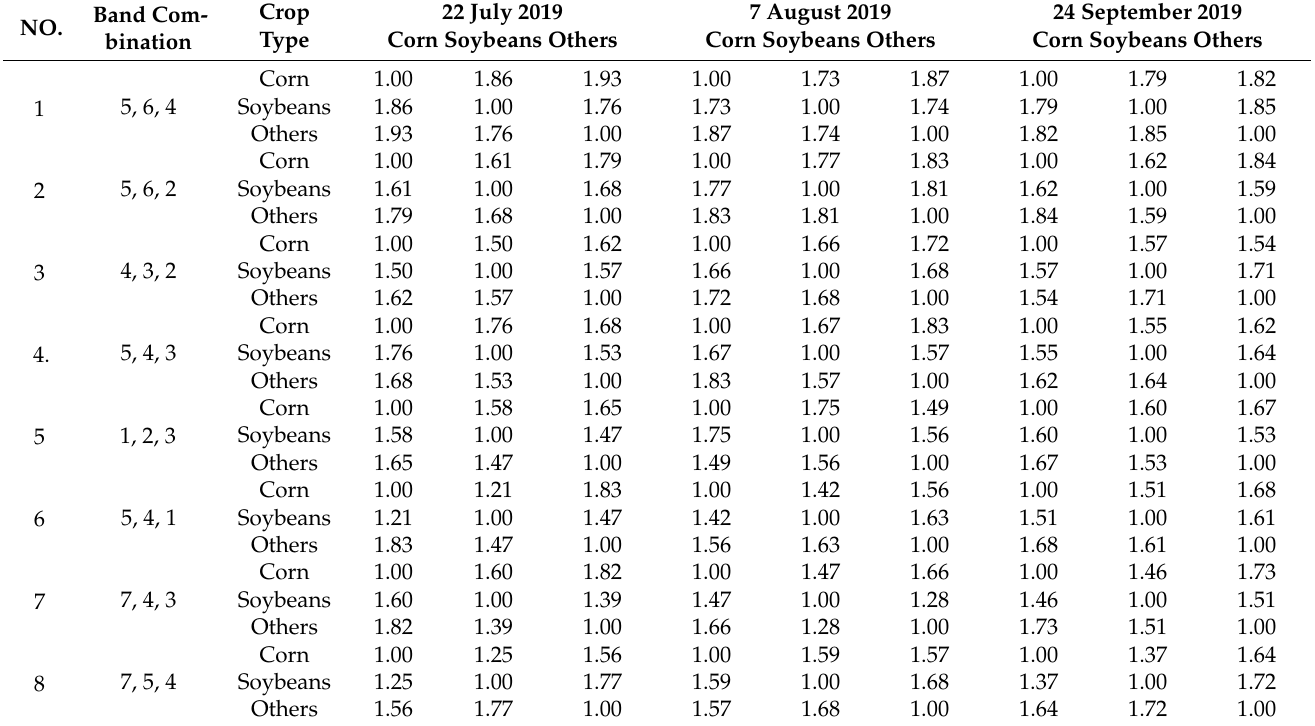
Table 1. Jeffries–Matusita distance of the three categories in different band combinations at different times.